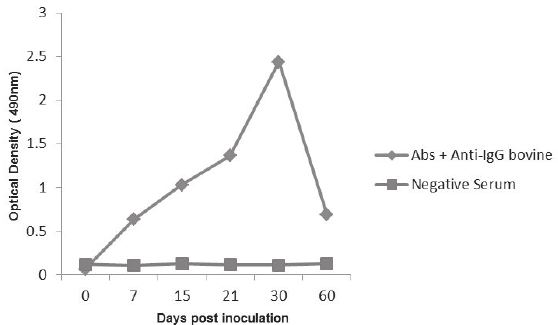
Figure 5 - Response kinetics of anti-bovine IgG antibodies in immunized pacu and non-immunized pacu (negative serum). Dilution of pacu serum (1:400). Data are presented as mean optical density ± SD (n= 10 per group). dpi: days post-